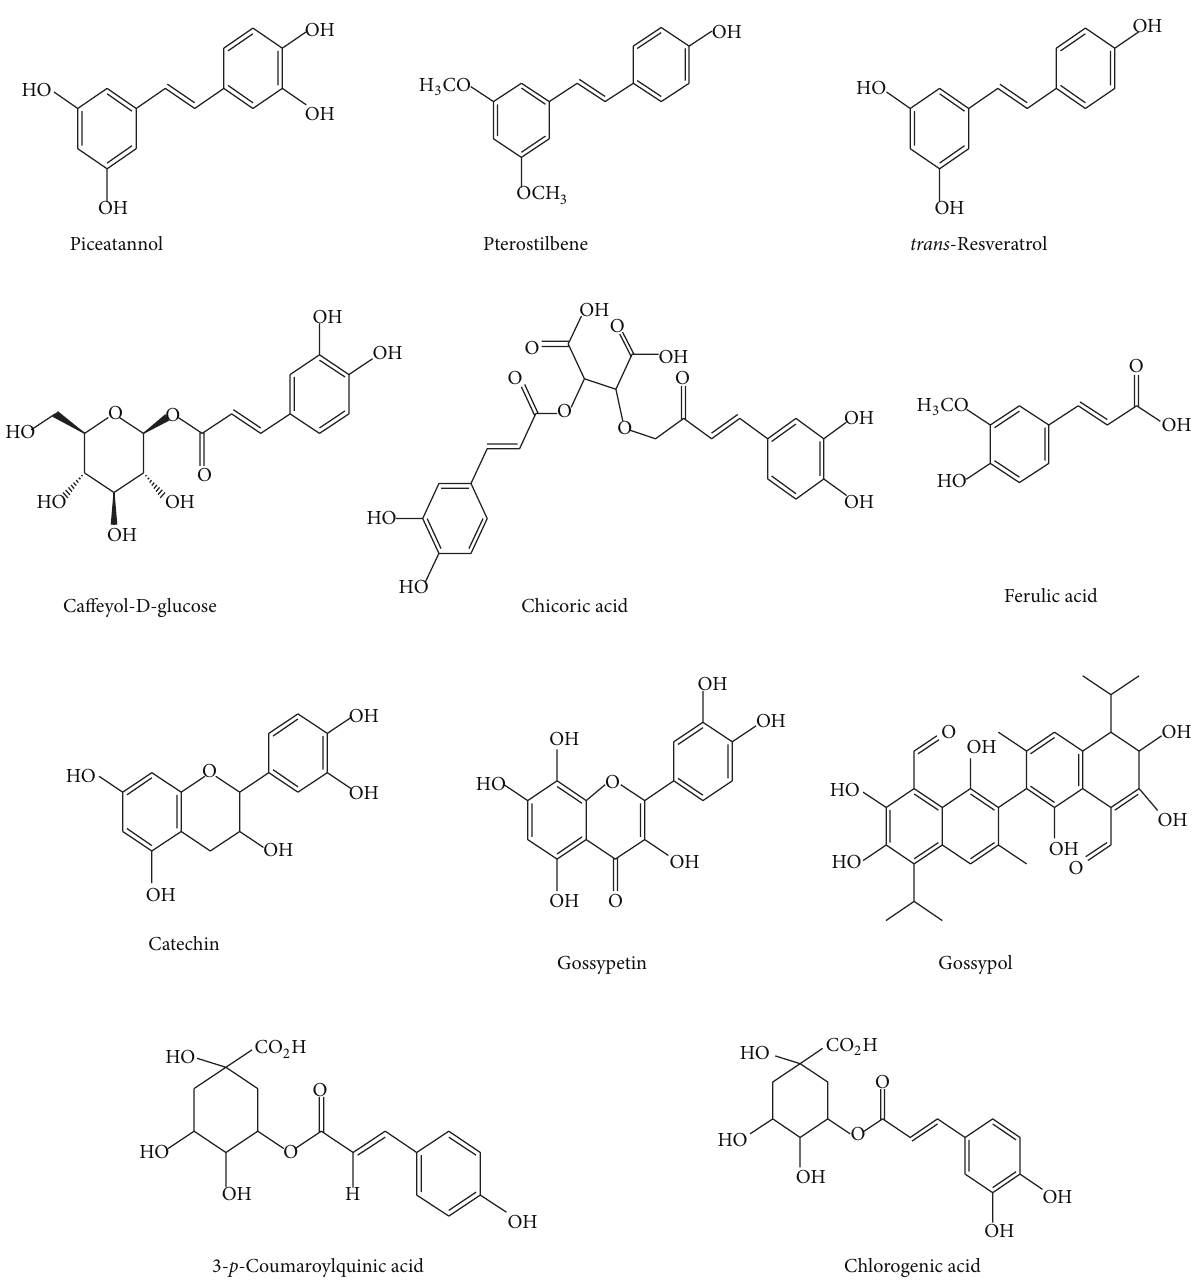
Figure 2: Phytoalexins isolated from cotton leaves. The compounds can be classified into five phenolic groups as follows: (i) stilbenoids: piceatannol, pterostilbene, and trans -resveratrol; (ii) hydroxycinnamic acids: caffeoyl-D-glucose, cichoric acid, and ferulic acid; (iii) chlorogenic acids: 3- p -coumaroylquinic acid and chlorogenic acid; (iv) flavonoids: catechin and gossypetin; (v) terpenoid aldehyde: